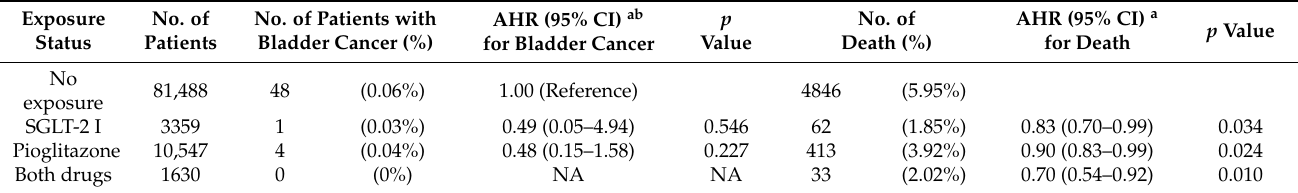
Table 3. Risks of bladder cancer and all-cause mortality according to exposure of study drugs. Exposure No. of Status Patients